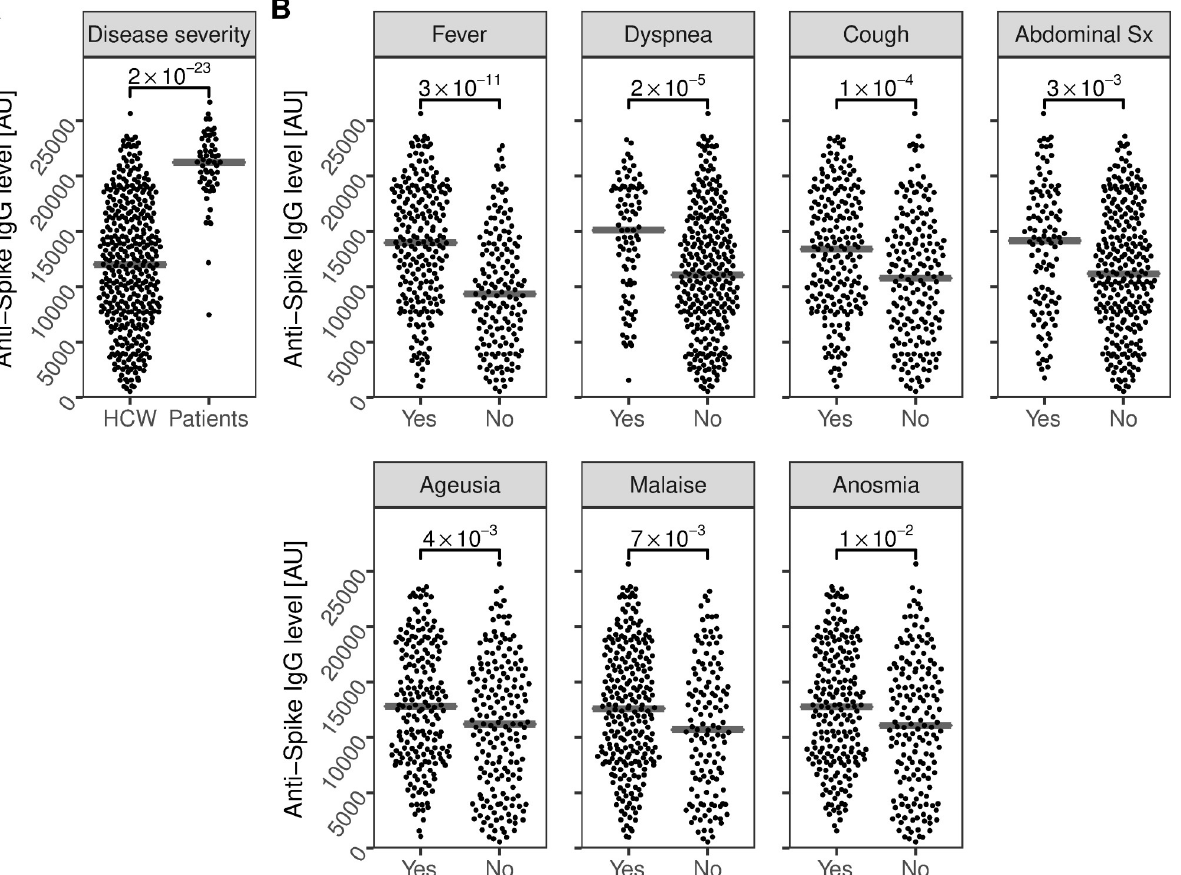
Fig 1. Four-month follow-up levels of anti-Spike IgG are associated to disease severity and COVID-19 symptoms. A) Four-month follow-up levels of anti-spike IgG were significantly higher in convalescent COVID-19 patients compared to HCW. B) In addition, four-month follow-up levels were significantly increased in HCW with self-reported fever, dyspnea, cough, abdominal symptoms, malaise, anosmia, or ageusia prior to study inclusion. Crossbars depict the median. P-values are shown with brackets. Sx; symptoms. AU: Arbitrary Units.